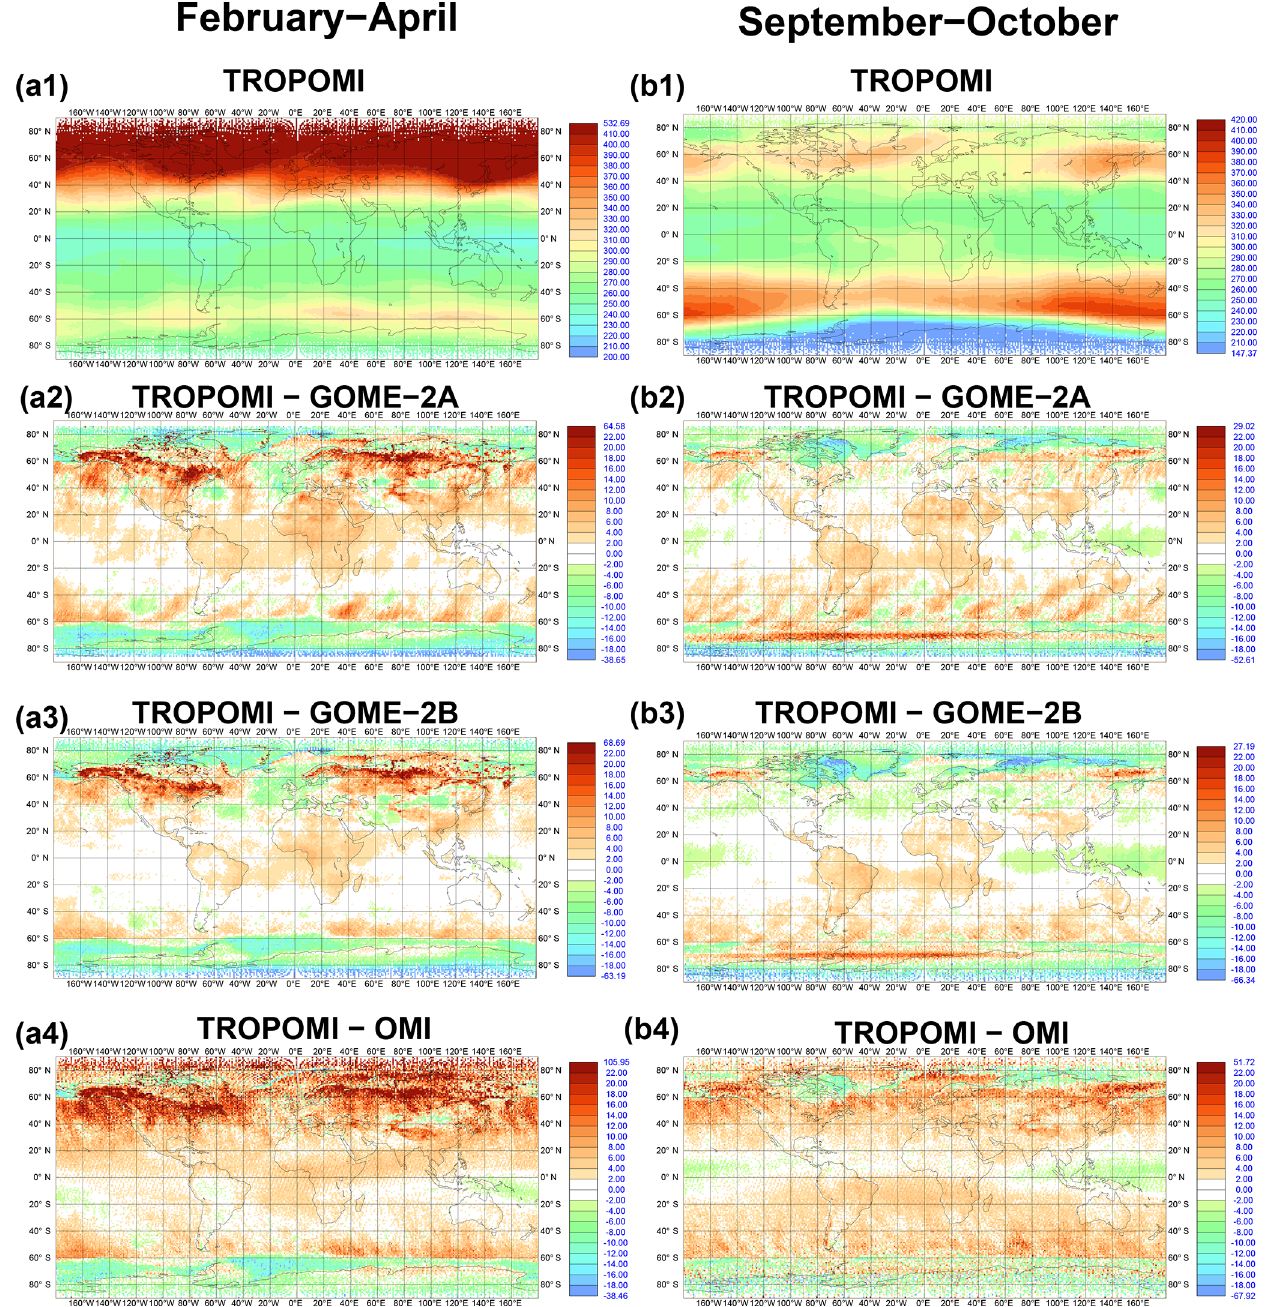
Figure 3. Averages over (a) FMA 2018 and (b) SON 2018. (1) Mean TROPOMI TCO3 fields, differences between (2) TROPOMI minus GOME-2A, (3) TROPOMI minus GOME-2B and (4) TROPOMI minus OMI. Only good data are shown. All values are in